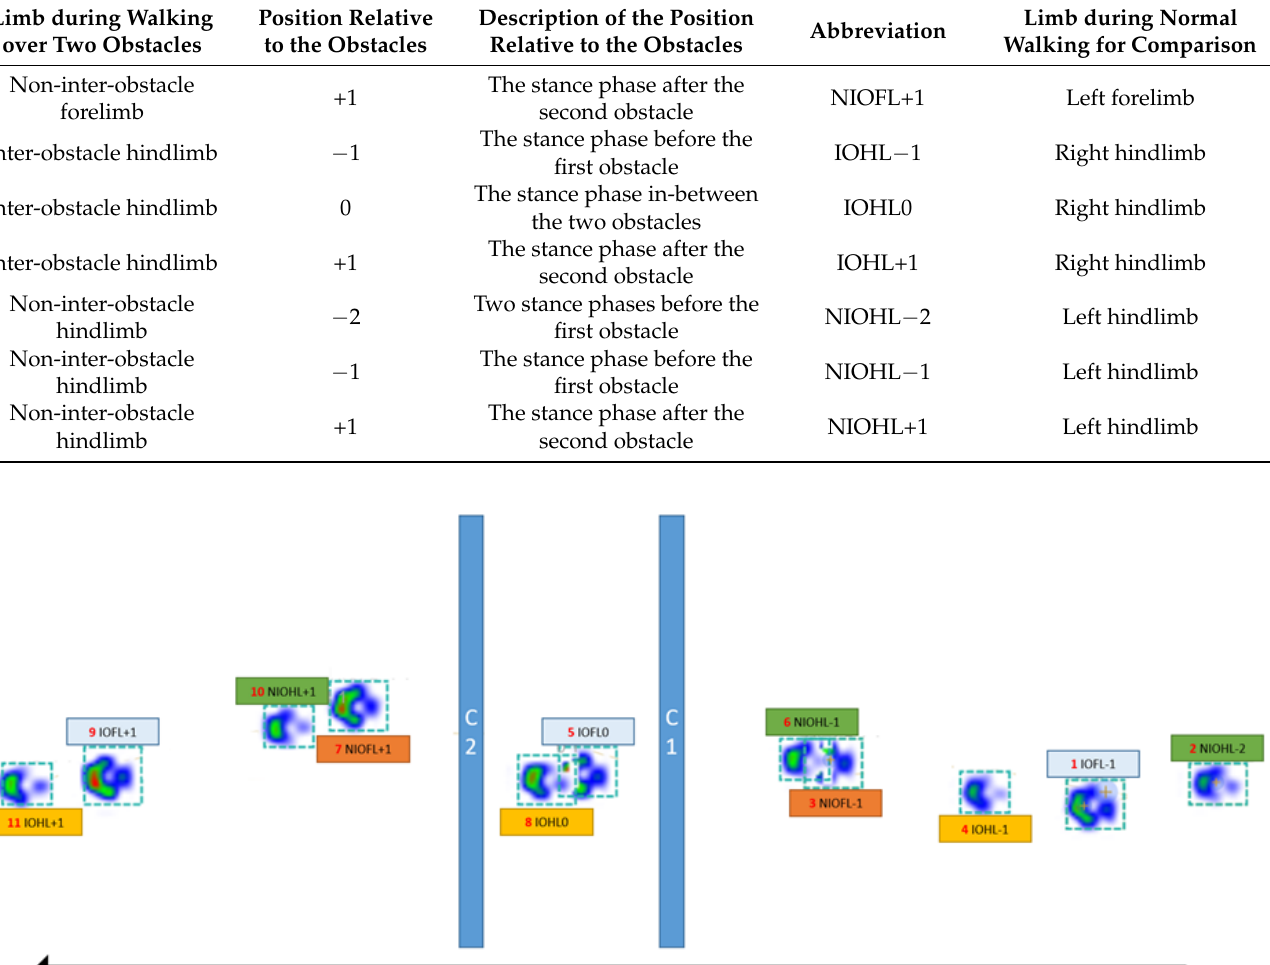
Figure 2. Labeling of the limbs when crossing two cavaletti (dog 1). Blue — forelimb which stepped between the obstacles, yellow — hindlimb which stepped between the obstacles, orange — forelimb which did not step between the obstacles, green—hindlimb which did not step between the obstacles; 0 —stance phase between the obstacle, −2—first stance phase before the cavaletti, −1— second stance phase before the cavaletti, +1 — first stance phase after the cavaletti. The red numbers indicate the order in which the paws touched the plate. Table 2. Description of the abbreviations used during walking over two obstacles and the limbs with which they were compared during normal walking.